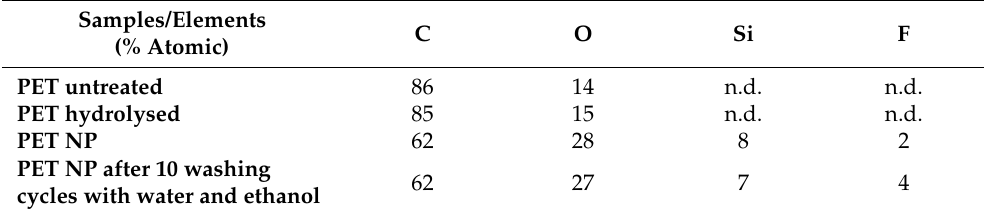
Table 3. SEM-EDS results for atomic concentrations of untreated and treated PET samples (n.d.: not detected).